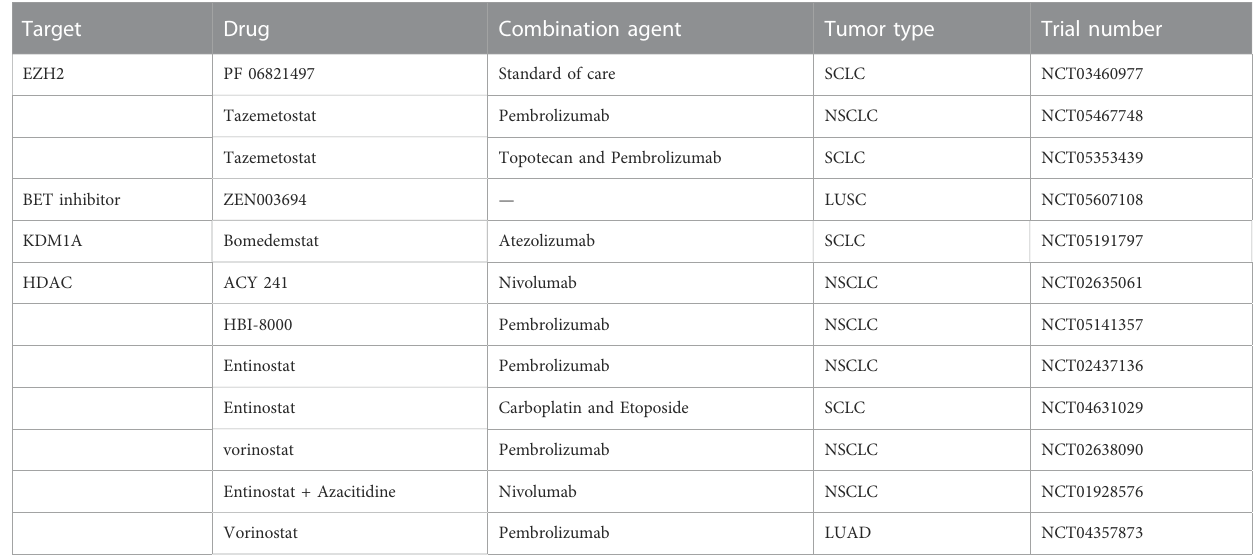
TABLE 2 Ongoing clinical trials of epigenetic drugs in lung